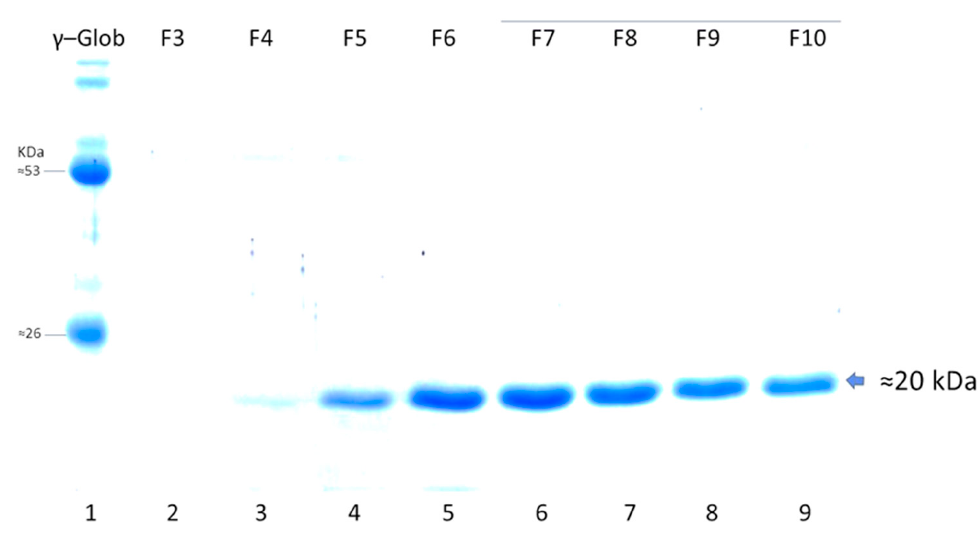
Figure 7. SDS-PAGE analysis of elution fractions during IMAC purification of LTB-RBD Wuhan. Lane 1: γ globulin from human blood as molecular weight marker, lanes 2 to 9: eluted fractions upon entrance of imidazole for protein desorption.